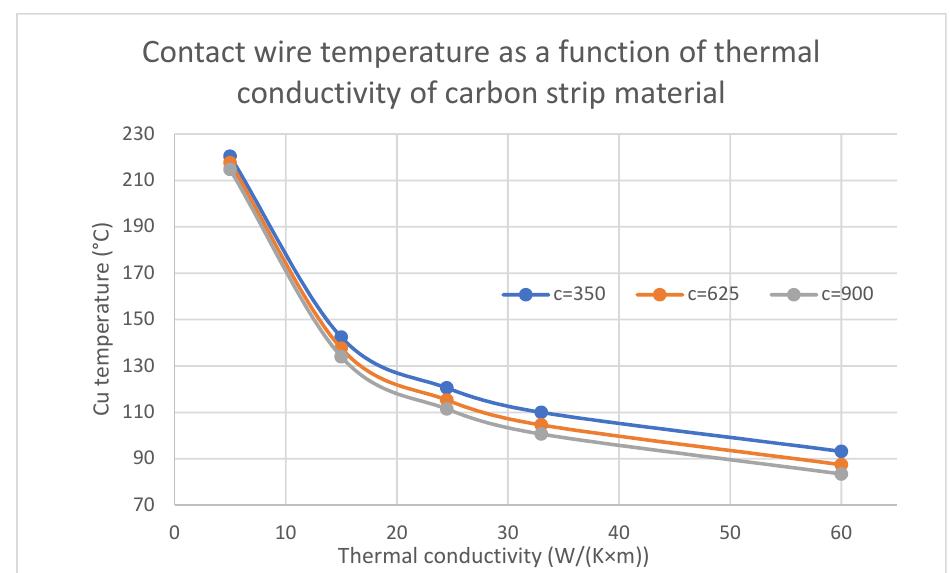
Figure 13. Contact wire temperature (Cu temperature °C) as a function of the thermal conductivity (W/Km) of the carbon strip material.